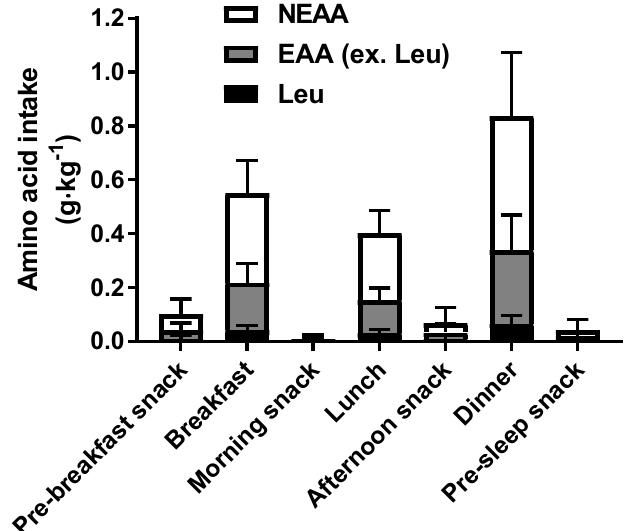
Figure 2. Distribution and composition of the dietary amino acid consumed throughout day 4. Data are shown as mean ± standard deviation ( n = 13). EAA, essential amino acid; NEAA, non-essential amino acid; Leu,